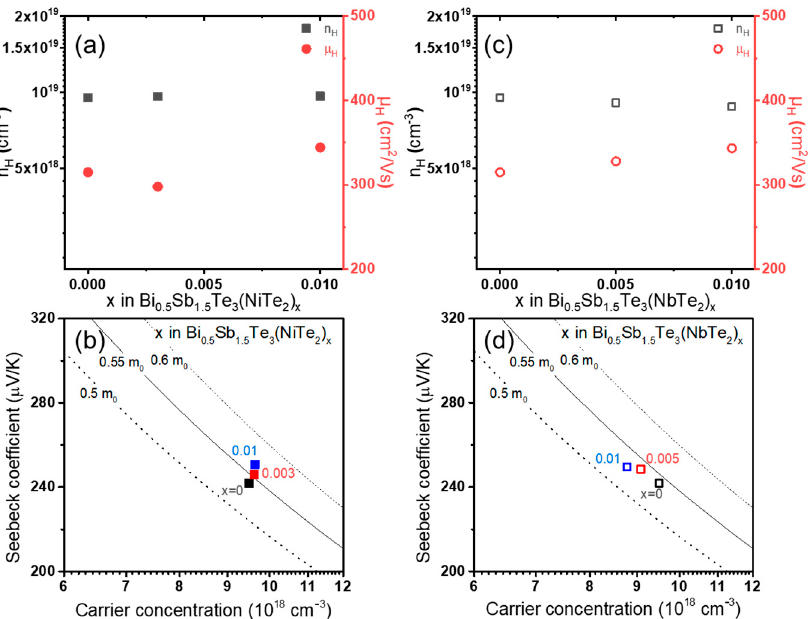
Figure 4. Carrier concentration and mobility for ( a ) Bi 0.5 Sb 1.5 Te 3 (NiTe 2 ) x ( x = 0, 0.003, 0.01) and ( c ) Bi 0.5 Sb 1.5 Te 3 (NbTe 2 ) x ( x = 0, 0.005, 0.01). Pisarenko plots ( S as a function of carrier concentration) for ( b ) Bi 0.5 Sb 1.5 Te 3 (NiTe 2 ) x ( x = 0, 0.003, 0.01) and ( d ) Bi 0.5 Sb 1.5 Te 3 (NbTe 2 ) x ( x = 0, 0.005, 0.01) at room temperature.